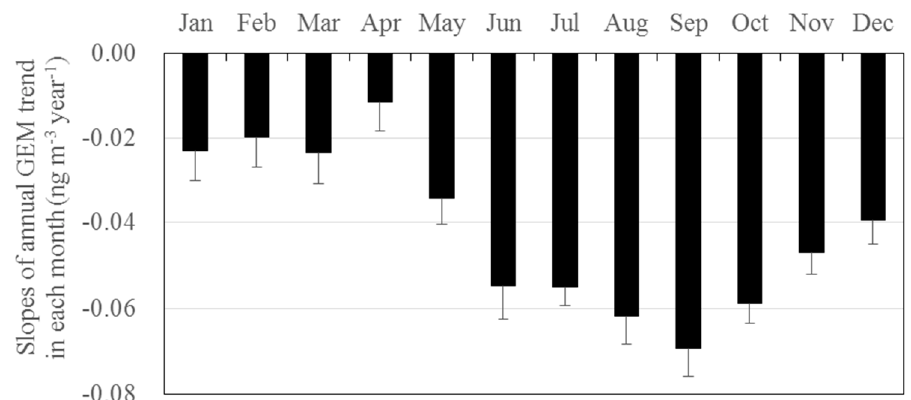
Figure 12. Annual trends in the slope of the least-squares regression based on the daily mean of GEM concentrations in each month.